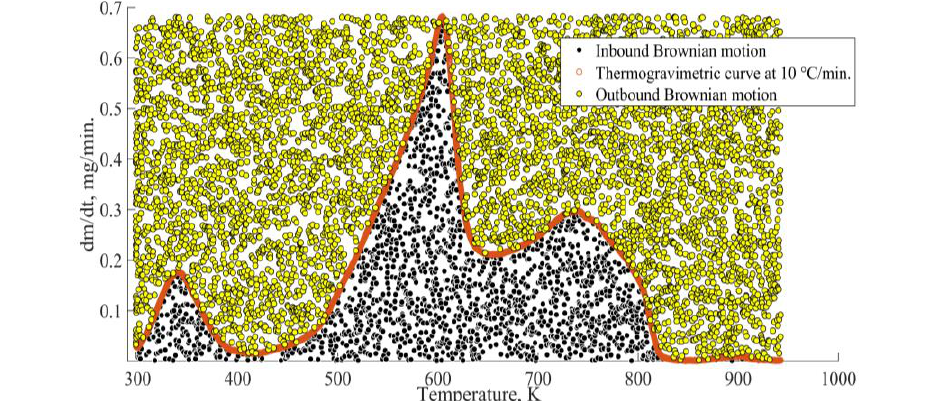
Fig. 2. Brownian motion of inbound and out bound particles on the DTG plane at 10 °C/min.